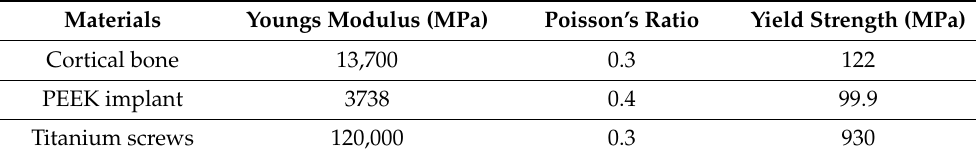
Figure 3. Modeling of the customized implant ( a ) asymmetrical skull defect; ( b ) identification of distorted region; ( c ) recognition of curves tangent to surface; ( d ) interpolation of curves; ( e ) surface generation; ( f ) surface acquired through curves; ( g ) splitting appropriate surface patch; ( h ) conversion of surface to part model; ( i ) implant placed on the skull. Table 2. Material properties used in the computational model